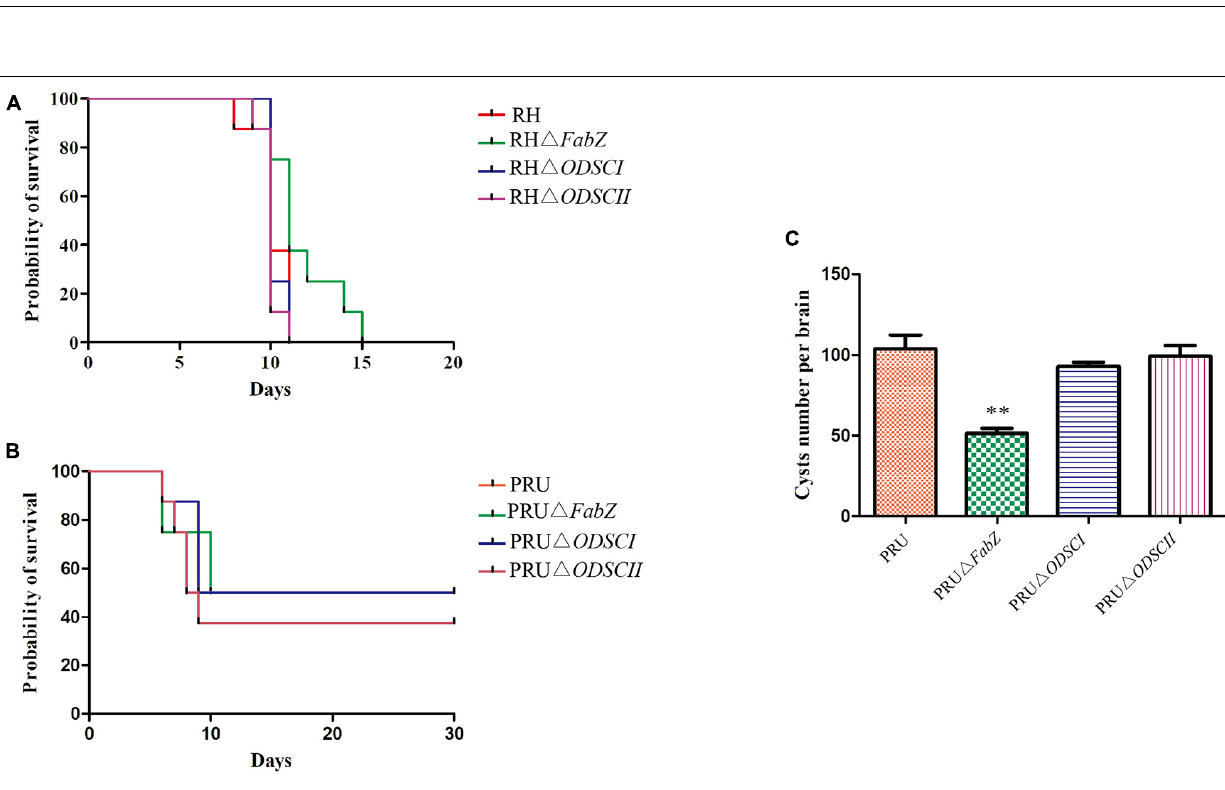
Frontiers in Microbiology |